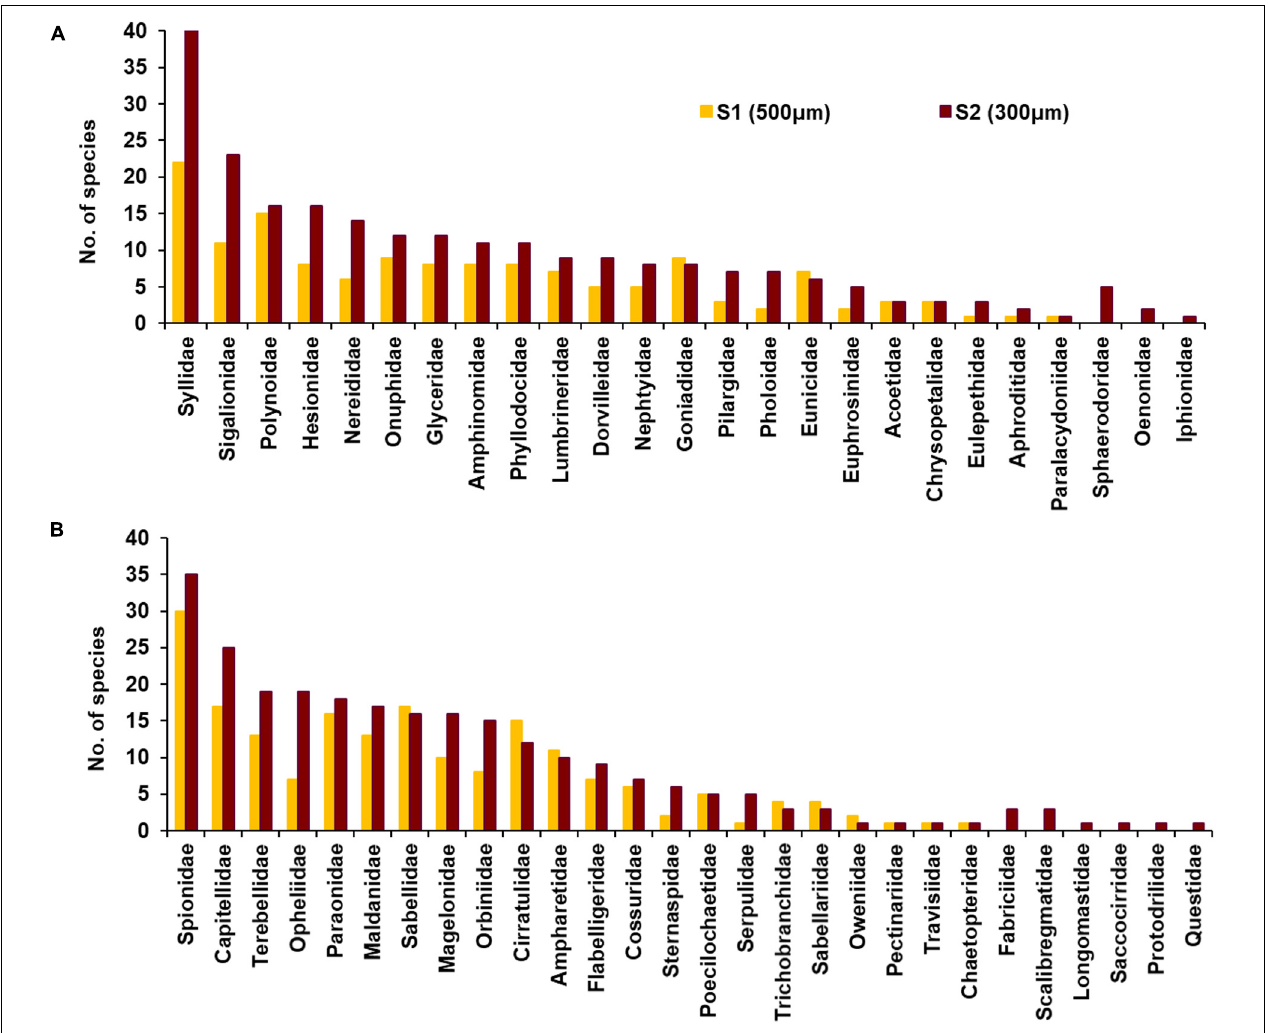
FIGURE 6 | Number of polychaete species represented among polychaete families, (A) Errantia and (B) Sedentaria in survey 1 (S1, yellow bars, 500 µ m) and survey 2 (S2, maroon bars, 300 µ m).